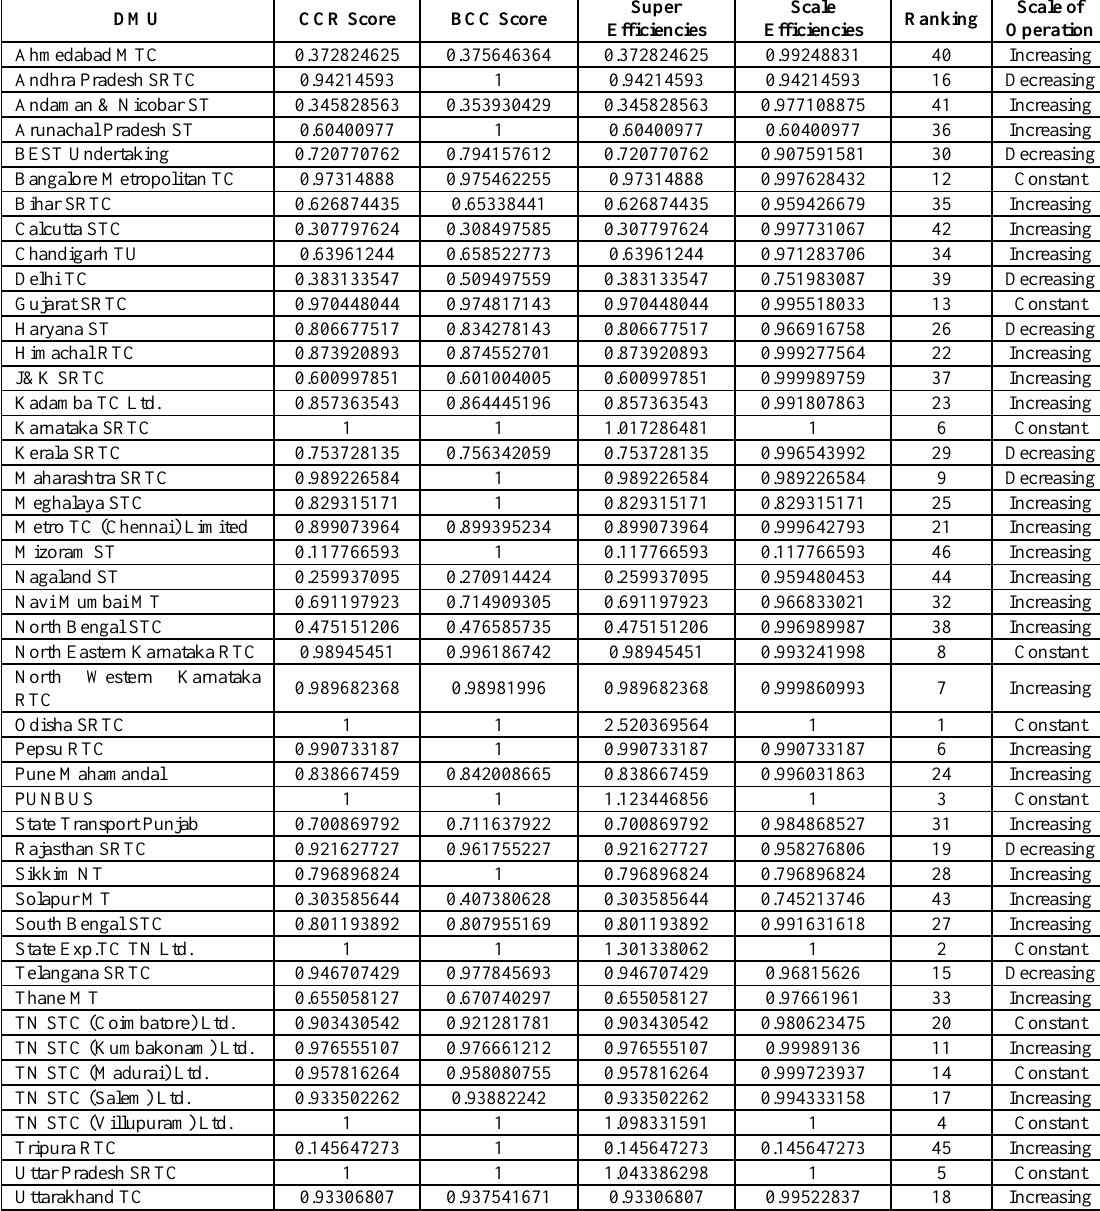
Table 3. Summary of efficiency